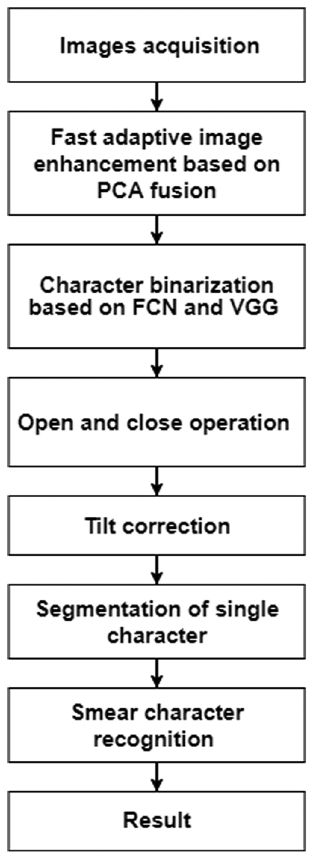
Figure 1: Character recognition fl ow chart of power